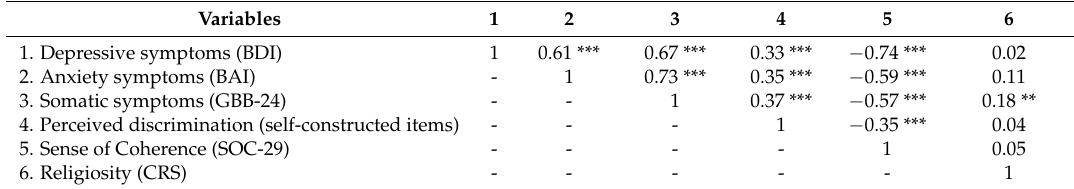
Table 3. Pearson’s correlation coefficients between central study variables in immigrants of Polish origin in